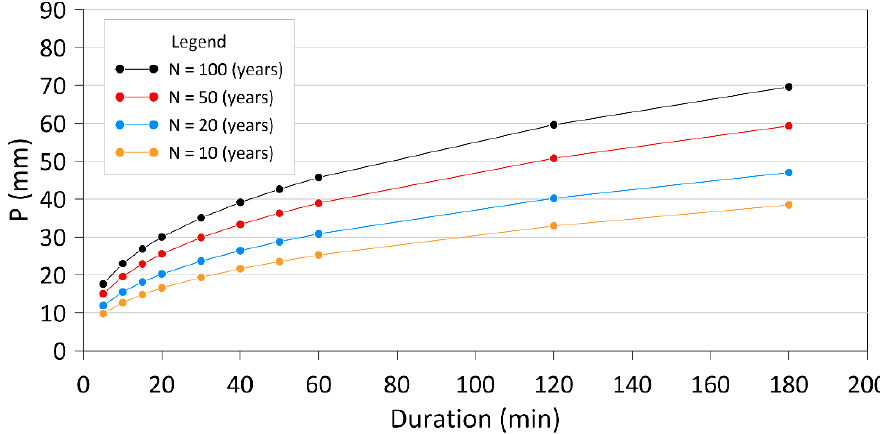
Figure 13. The future downscaled design rainfall intensities for the Vyšná Boca climatological station.